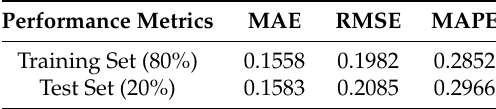
Table 4. Summary of RF performance